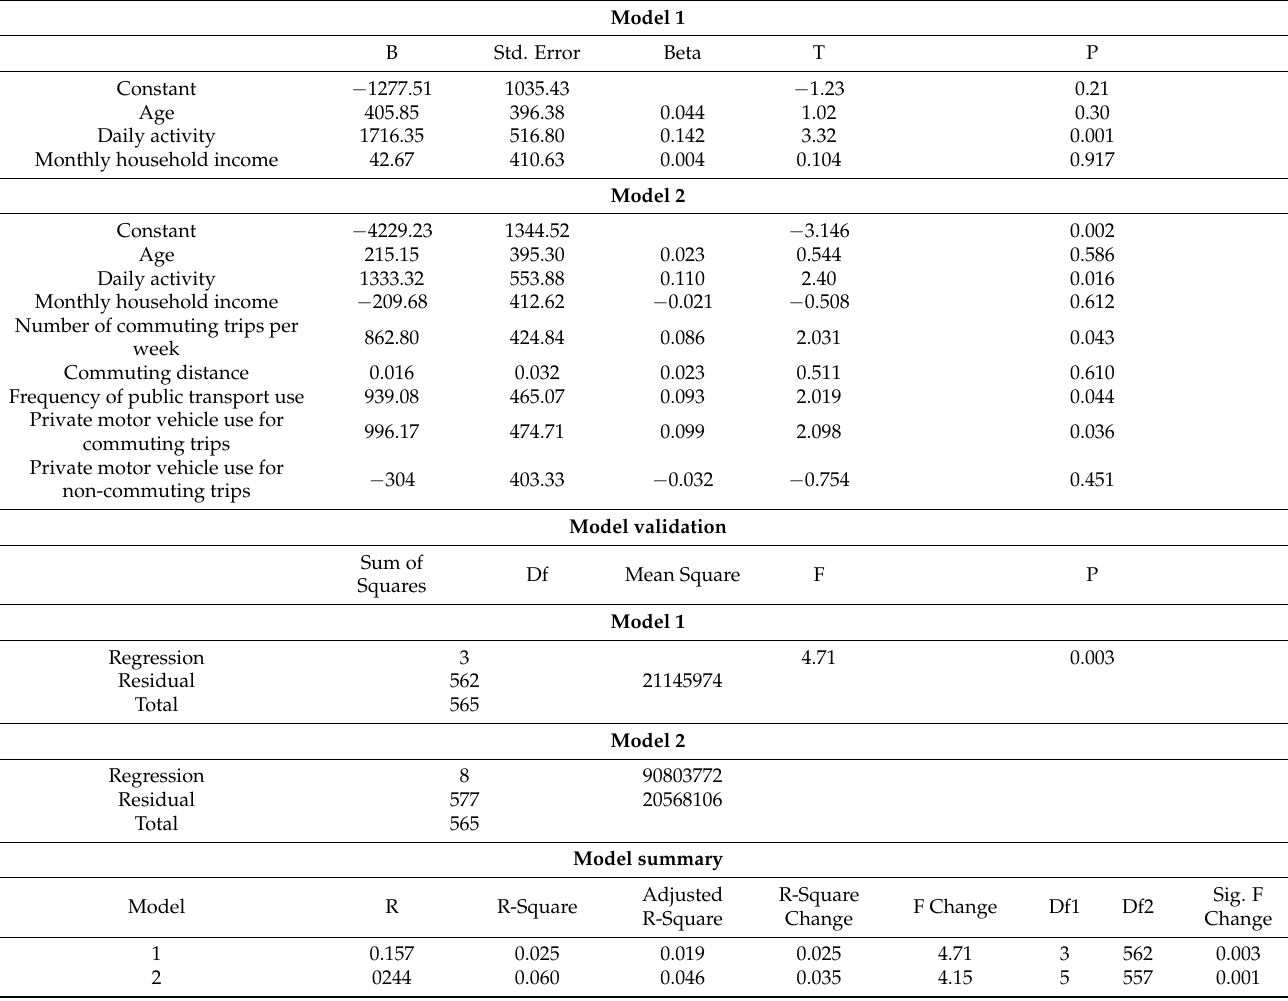
Table 2. HMR model for street-length density around